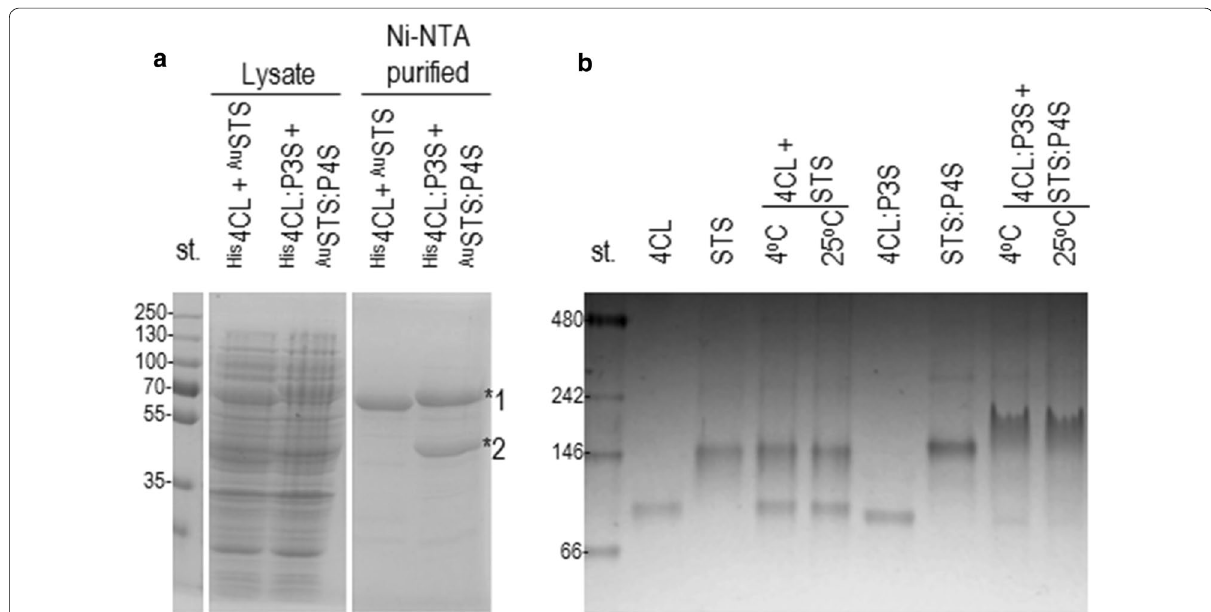
Fig. 3 NiNTA-isolated coiled-coil-forming domains fused with enzymes interact and form clusters in vitro. a The SDS PAGE of the NiNTA-isolated proteins demonstrates the interaction between P3S and P4S from fusion proteins His 4CL:P3S (*1) and AU STS:P4S (*2). b Native PAGE analysis revealed that in vitro clusters of 4CL and STS are formed at two different temperatures only on the fusion of enzymes with the coiled-coil-forming segments P3S and P4S